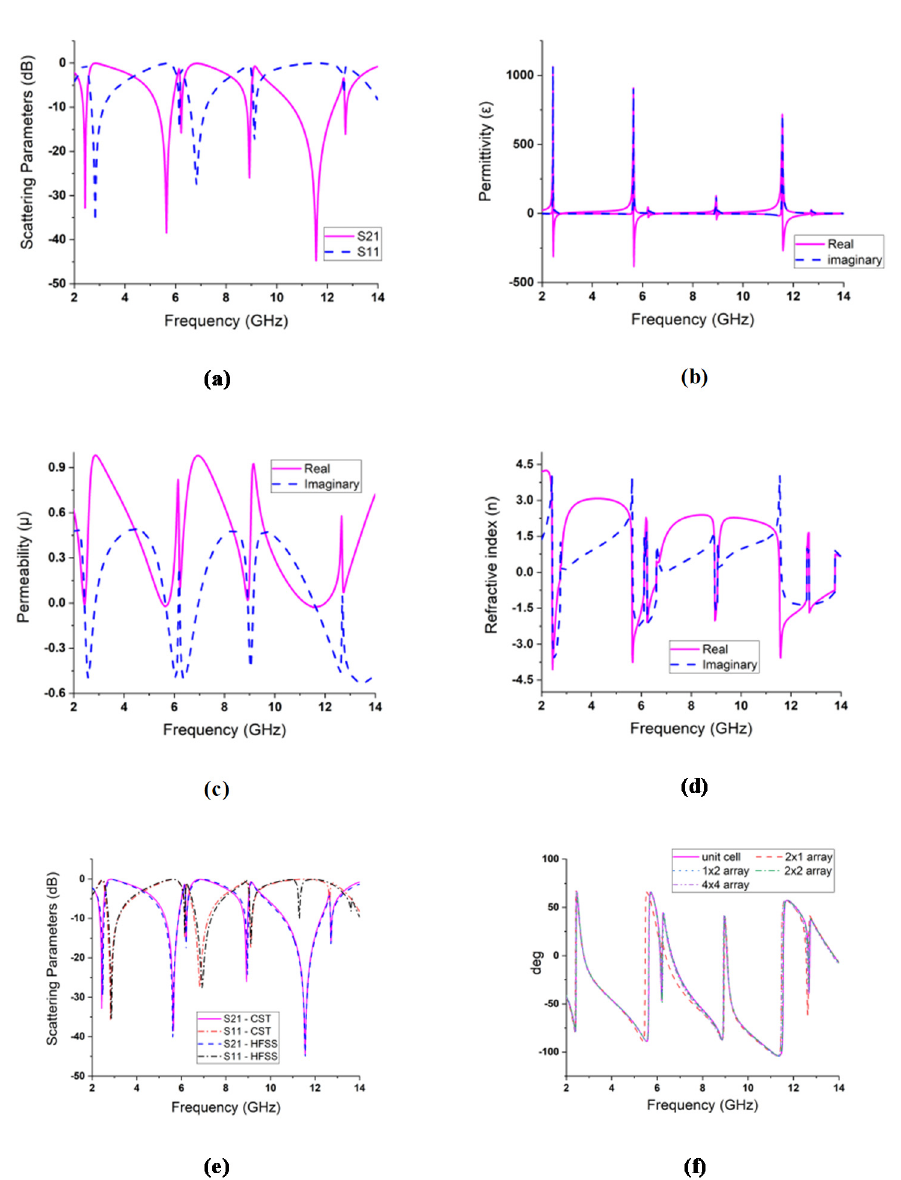
Figure 11. ( a ) Transmission coefficient and reflection coefficient, the real and imaginary part; ( b ) rela- tive permittivity; ( c ) relative permeability; ( d ) refractive index; ( e ) transmission coefficient reflection coefficient results between CST and HFSS simulator; ( f ) simulated S21 phase of unit cell and arrays.